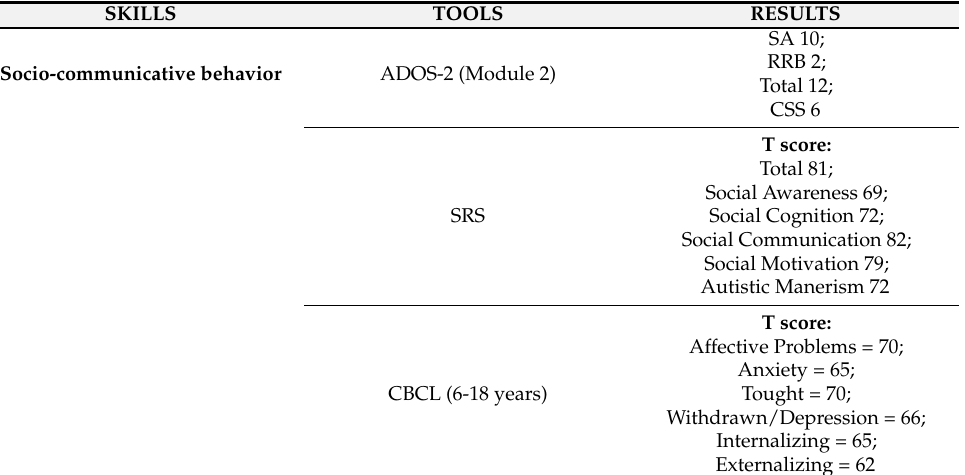
Table A1. Cont . SKILLS TOOLS